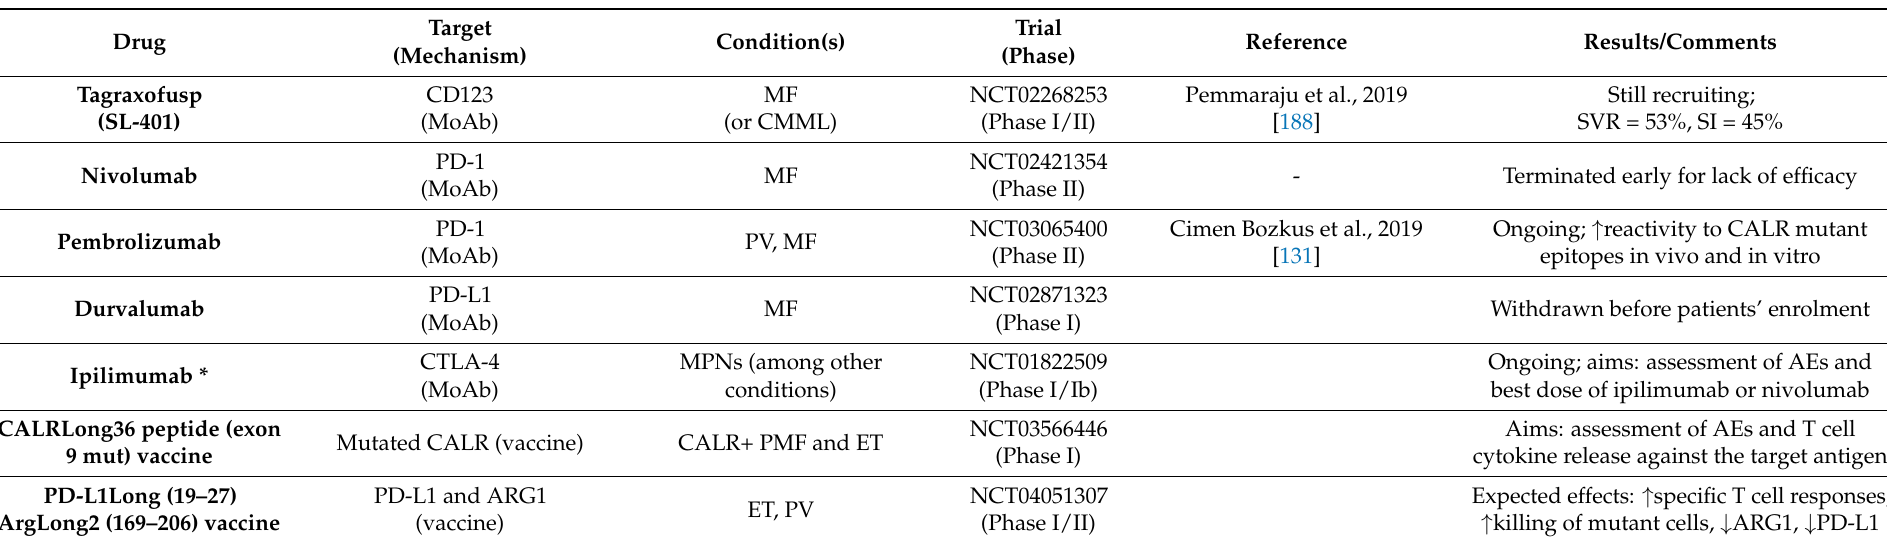
Table 2. Selected clinical trials investigating anti-CD123, immune checkpoint inhibitors (ICIs) and tumor vaccination in